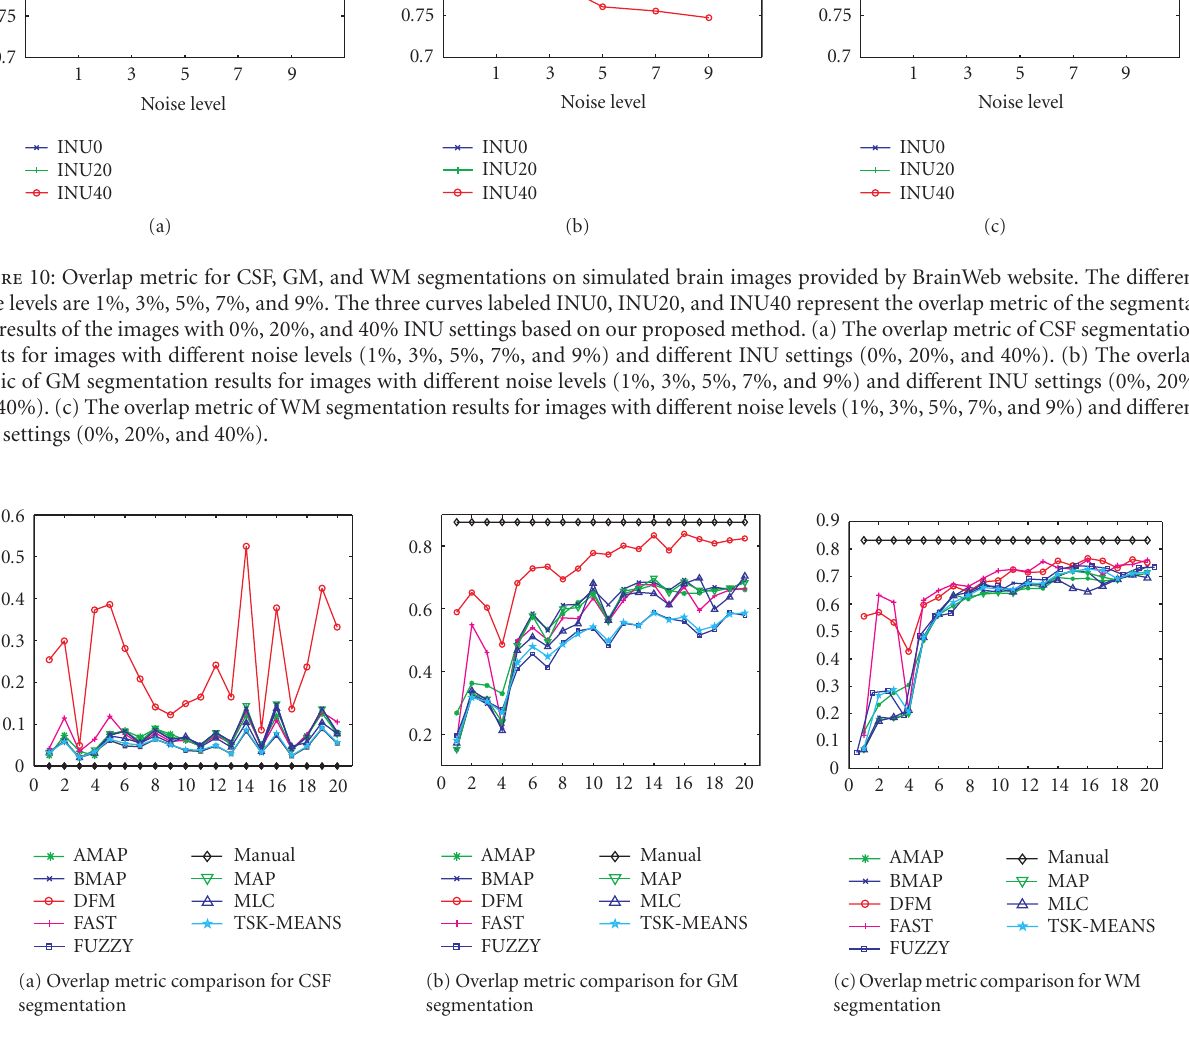
Figure 11: The overlap metric of CSF, GM, and WM segmentations results on 20 normal real brain images for various segmentation methods. The results of some automatic segmentation methods provided by IBSR. AMAP: adaptive MAP; BMAP: biased MAP; FUZZY: fuzzy C -means; MAP: maximum a posteriori probability; MLC: maximum likelihood; TSKMEANS: tree-structure k -means; FAST: hidden Markov method [28]; DFM: our